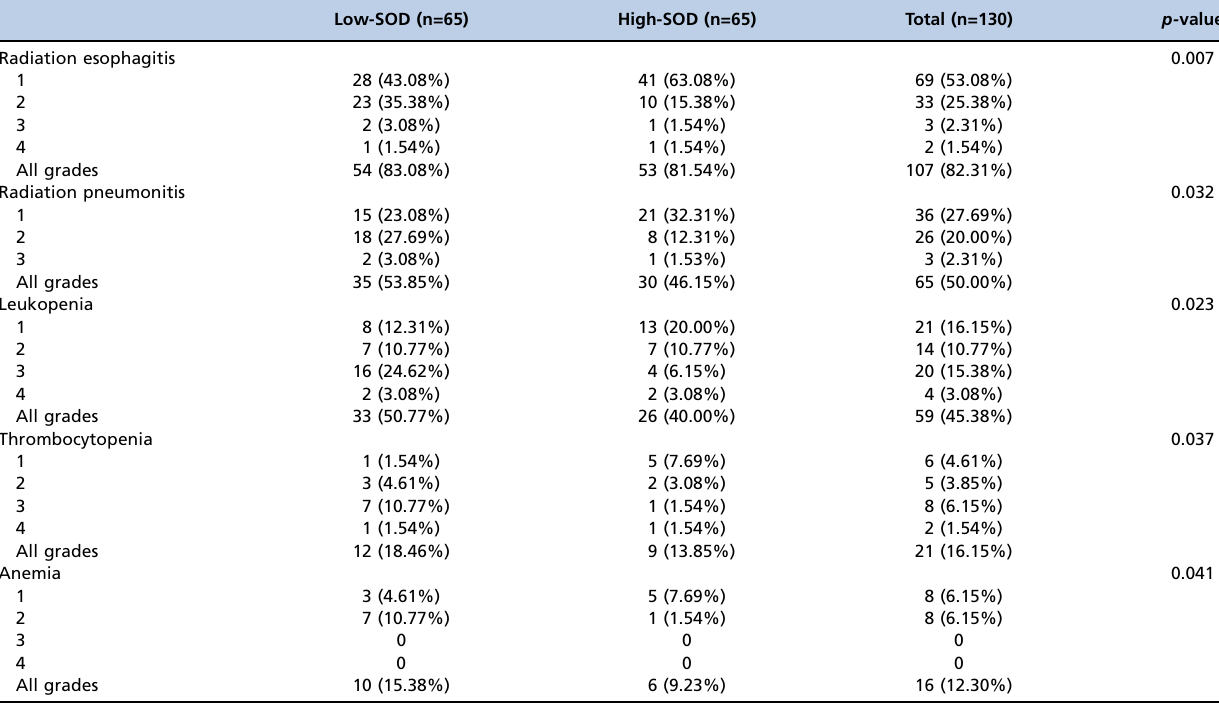
Table 2 - Toxicity of patients in the low- and high-Superoxide dismutase groups. Low-SOD (n=65)